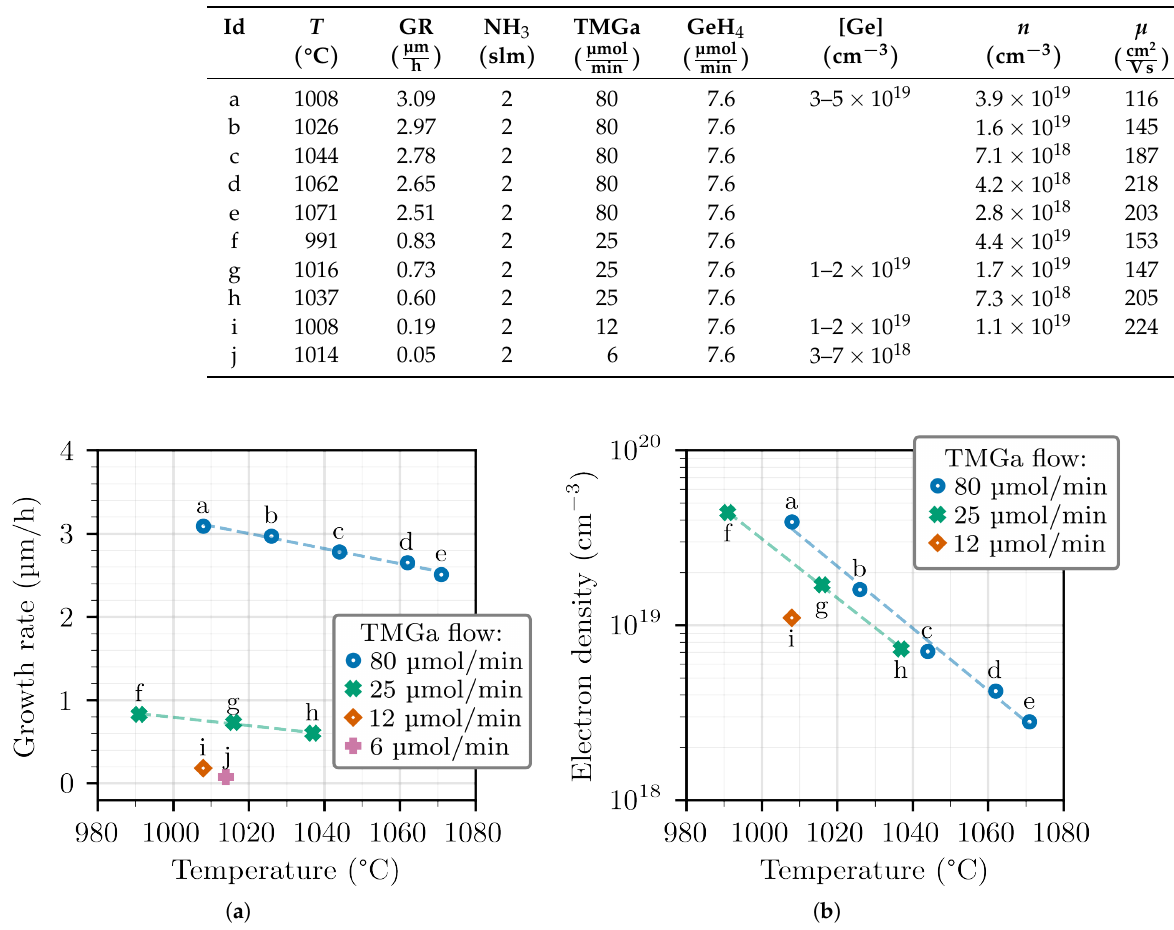
Table 1. Summary of the growth conditions and characterization results of the first series of samples, where only the growth temperature and the TMGa flow were varied. The [Ge] column shows the concentration of germanium impurities in the test layers as measured by SIMS. The n and µ columns show the electron density and mobility from the Hall-effect measurements.